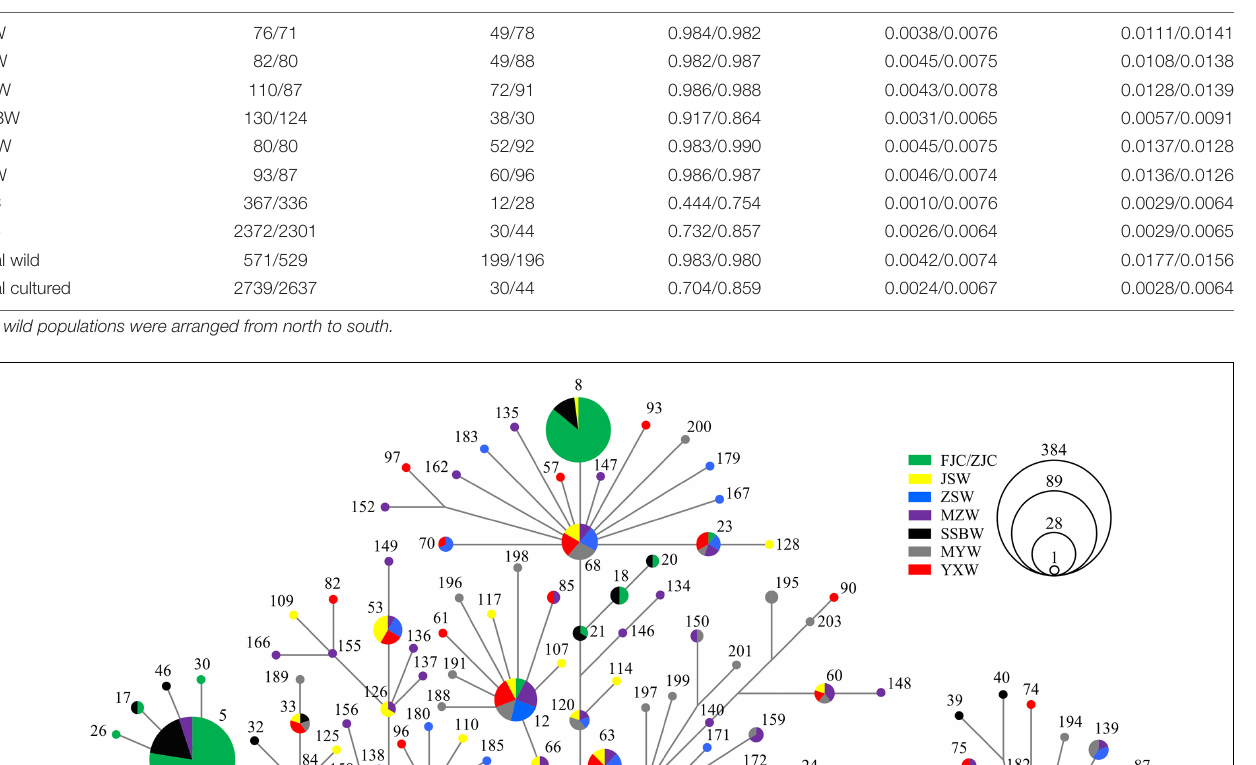
TABLE 1 | The genetic diversity parameters based on mtDNA (former) and nuDNA (latter) fragments. Population